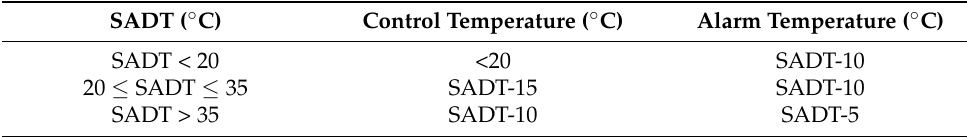
Table 12. Relationship between control temperature, alarm temperature, and